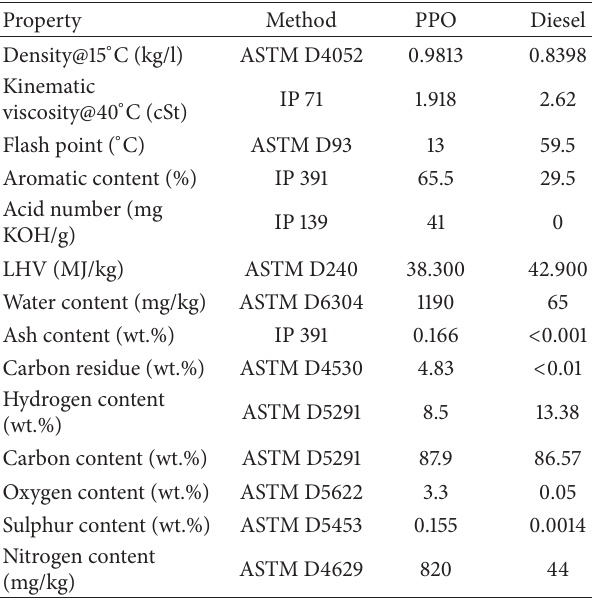
Table 1: PPO and diesel properties.